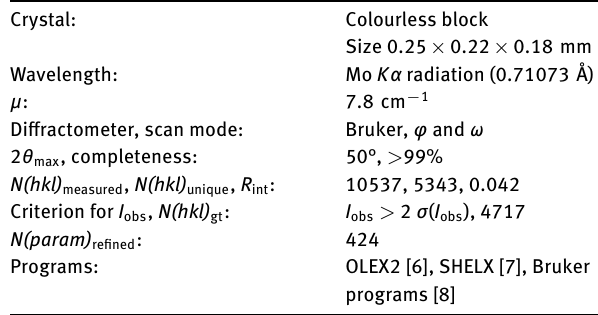
Table 1: Data collection and